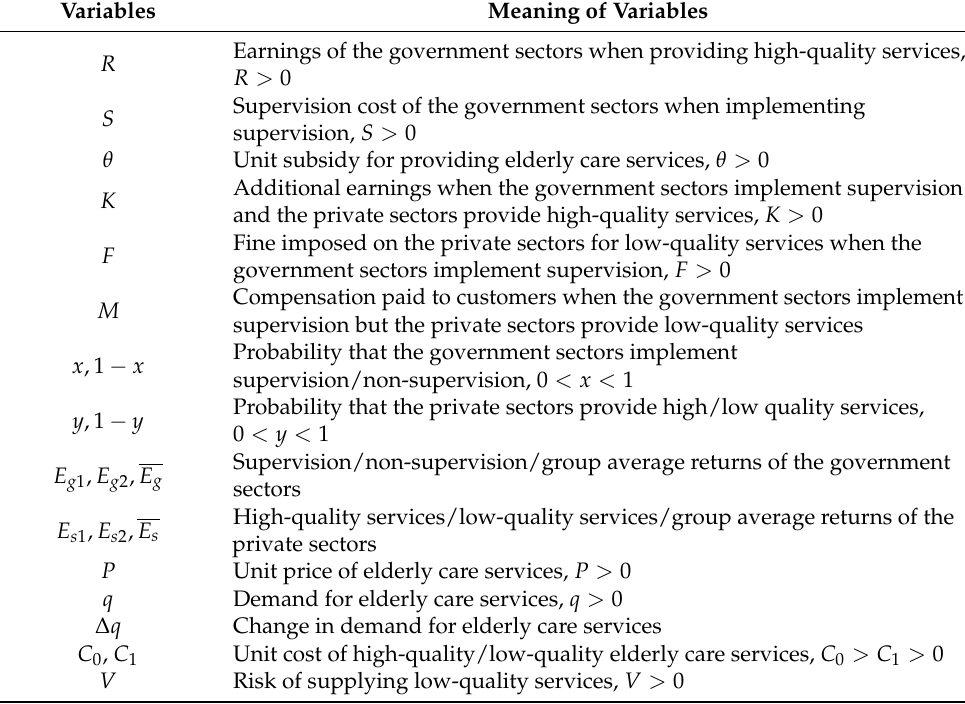
Table 1. Variables and